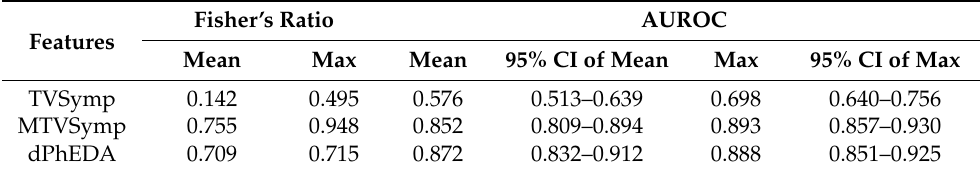
Table 4. Statistical analysis on difference between painless and pain segments for EP